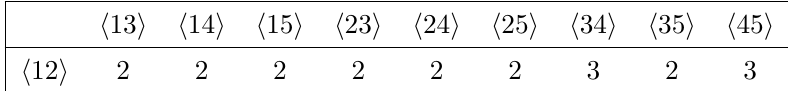
Table 2 . Doubly singular limits for h 12 i in A